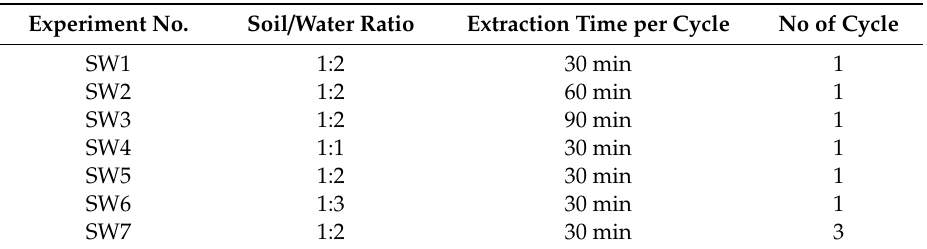
Table 1. Details of soil washing